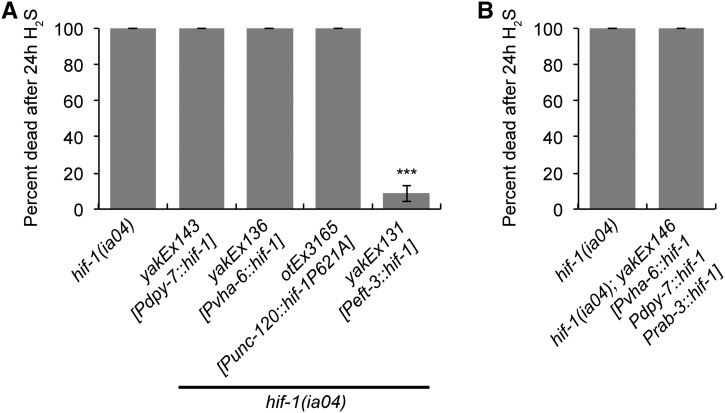
Survival in H2S requires broad expression of hif-1. Survival of animals exposed to H2S. All animals have the null hif-1(ia4) mutation. (A) Lethality of animals that express hif-1 only in hypodermis (Pdpy-7::hif-1; yakEx143), intestine (Pvha-6::hif-1; yakEx136), or muscle (Punc-120::hif-1(P621A); otEx3165). As a control, hif-1 was expressed from a ubiquitous promoter (eef-1A.1::hif-1; yakEx131). Expression was from extrachromosomal arrays. Wild-type hif-1 was used for all constructs except the Punc-120::hif-1(P621A), which expresses the nondegradable variant. (B) Survival of hif-1(ia4); yakEx146 animals exposed to H2S that express hif-1 simultaneously in intestine (Pvha-6::hif-1), hypodermis (Pdpy-7::hif-1), and neurons (Prab-3::hif-1). Average of three independent experiments is shown, each with n = 20–35 animals. Error bars are SEM. In all panels, statistical comparisons were to hif-1(ia4) controls. Statistically significant differences are indicated with *** P < 0.001 (Fisher’s exact test).